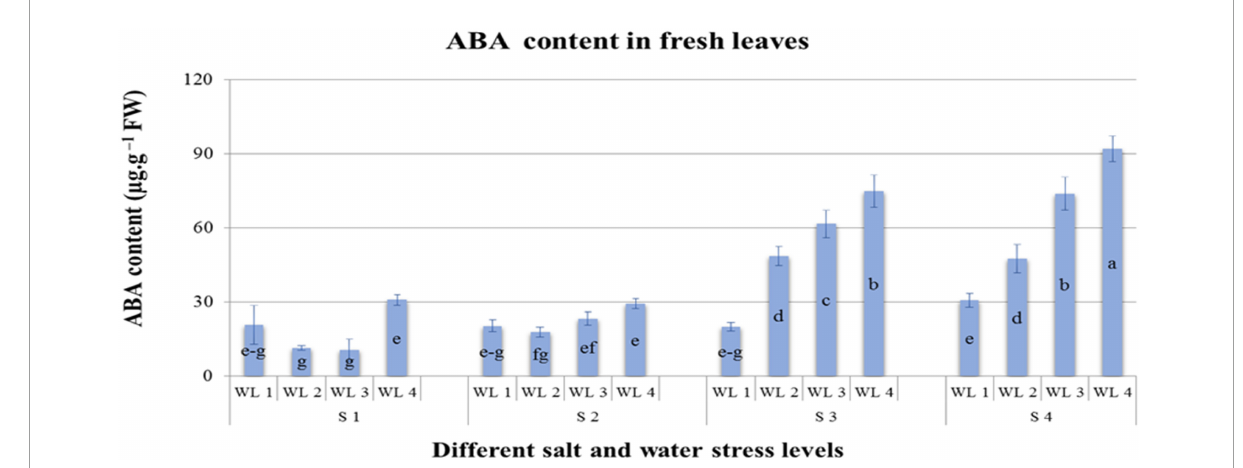
FIGURE1 Interactive effect of salinity and drought stress on ABA content ( µ g. g − 1 FW) content of Atriplex leucoclada . Error bars represent the standard error of the mean ( n = 3). WL stands for water level (WL1 = 100% field capacity, WL2 = 80% field capacity, WL3 = 60% field capacity and